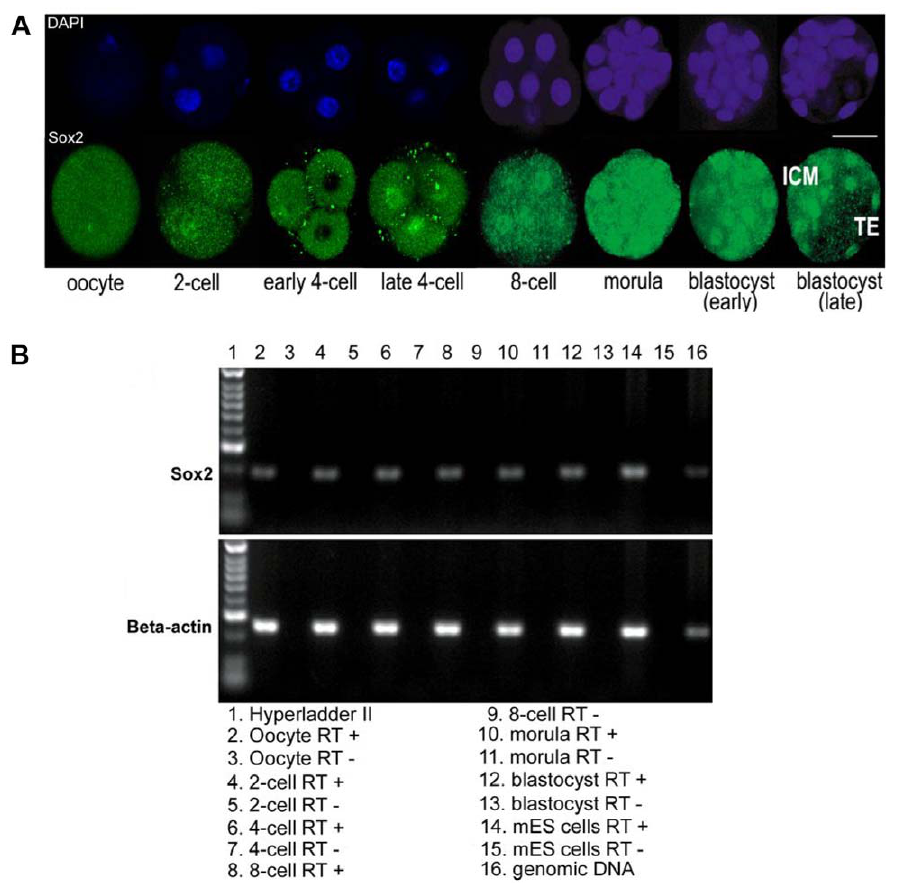
Figure 1. Sox2 (protein and mRNA) expression in mouse preimplantation development. Expression of Sox2 was detected at all stages (oocyte to blastocyst) of mouse preimplantation development by immunocytochemistry and RT-PCR. ( A ) Developmental stages of preimplantation mouse embryos immunostained for Sox2 (Abcam): single optical sections of confocal Z-series. Bar: 50 m m. ( B ) RT-PCR for Sox2 and b -actin in mouse preimplantation embryos, 40 cycles. Lane 1: Hyperladder IV (Bioline); 2: oocyte; 4: 2-cell; 6: 4-cell; 8: 8-cell; 10: morula; 12: blastocyst; 14: mES cells (line E14 ); 16: genomic DNA (Bioline). Lanes (3, 5, 7, 9, 11, 13, 15): RT –ve controls for each developmental stage.